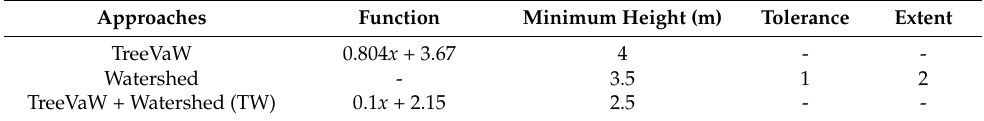
Table 2. Key parameters used in the tree segmentation approaches.